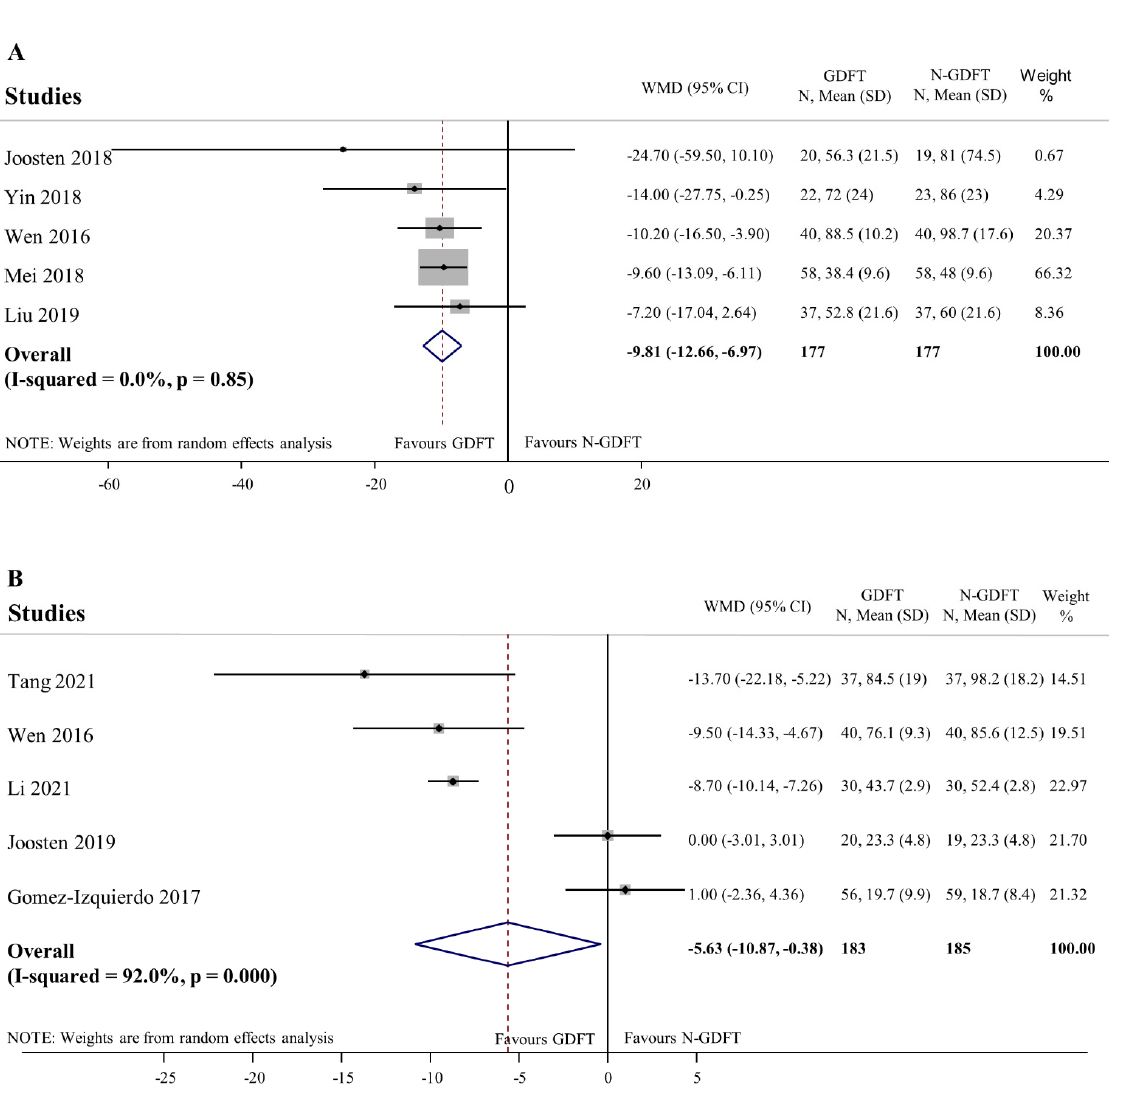
Figure 3. Time to first stool and time to first flatus. Time to first stool ( A ) was significantly reduced in patients receiving GDFT compared to the controls (WMD = − 9.81 h; 95%; CI = − 12.66 h to − 6.97 h). No evidence was found for heterogeneity (I-squared = 0.0%; p = 0.85). Time to first flatus ( B ) was signifi- cantly shortened in the GDFT group compared to the controls (WMD = − 5.63 h; 95% CI = − 10.87 h to 0.38 h). High heterogeneity was detected (I-squared = 92.0%; p < 0.01). WMD: weighted mean differ- ence, SD: standard deviation, GDFT: goal-directed fluid therapy, N-GDFT: non-goal-directed fluid therapy, CI: confidence interval. p < 0.1 was considered significant.